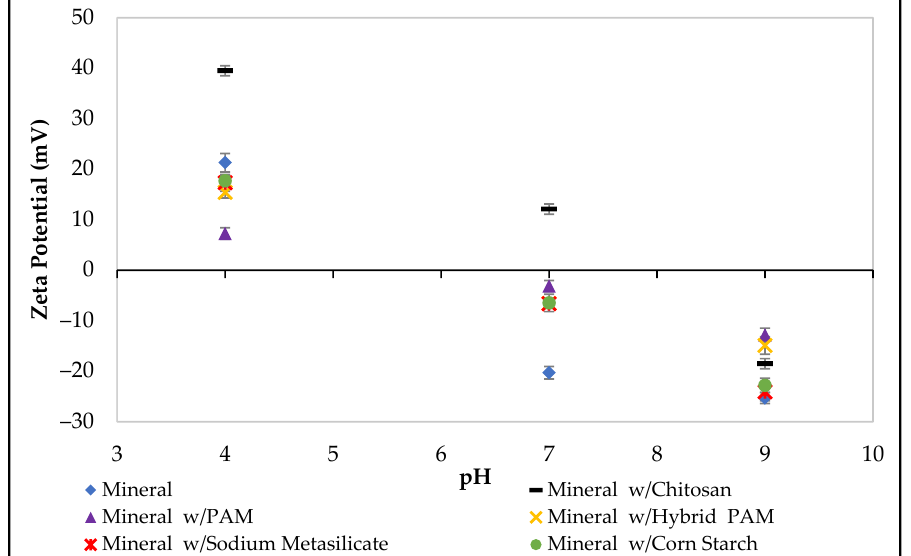
Figure 4 . Zeta potential measurements of magnetite suspensions with the selected depressants at pH 4, 7, and 9.